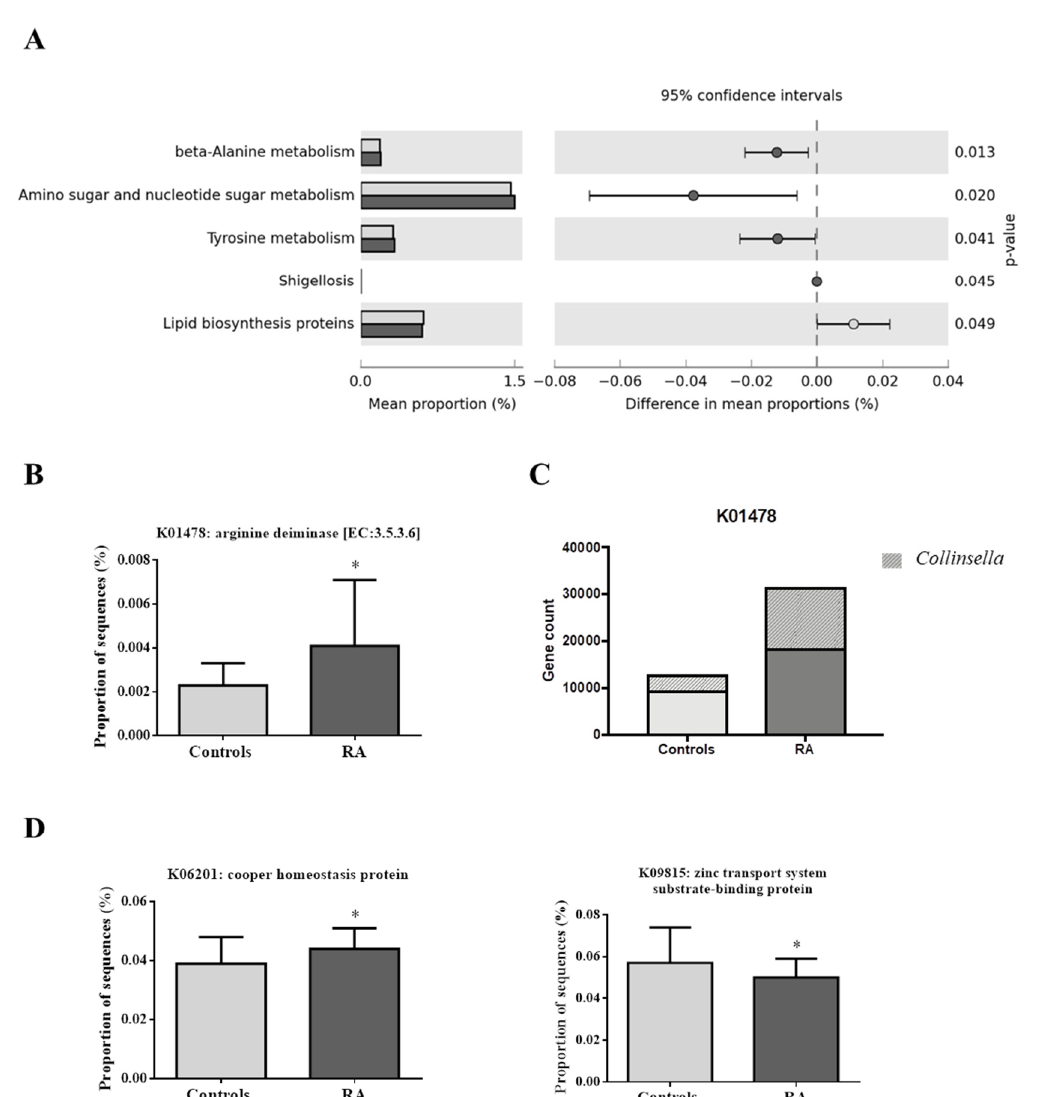
Figure 4. ( A ) Significant di ff erences in metabolic capacities of the gut microbiota among controls (light grey) and RA patients (dark grey). Only functional capacities with p -value < 0.05 are shown. Figure 4. A ) Significant differences in metabolic capacities of the gut microbiota among controls (light ( B ) Kyoto Encyclopedia of Genes and Genomes (KEGG) category showed significant di ff erences in grey) and RA patients (dark grey). Only functional capacities with p - value <0.05 are shown. B ) Kyoto the enzyme arginine deiminase, between controls and RA patients. ( C ) Arginine deiminase gene count in controls and RA patients, and Collinsella contribution. ( D ) KEGG category showed significant di ff erences in the copper homeostasis protein and zinc transport system substrate-binding protein among controls and RA patients. * indicates significant di ff erences vs. controls ( p -value < 0.05). RA, Rheumatoid